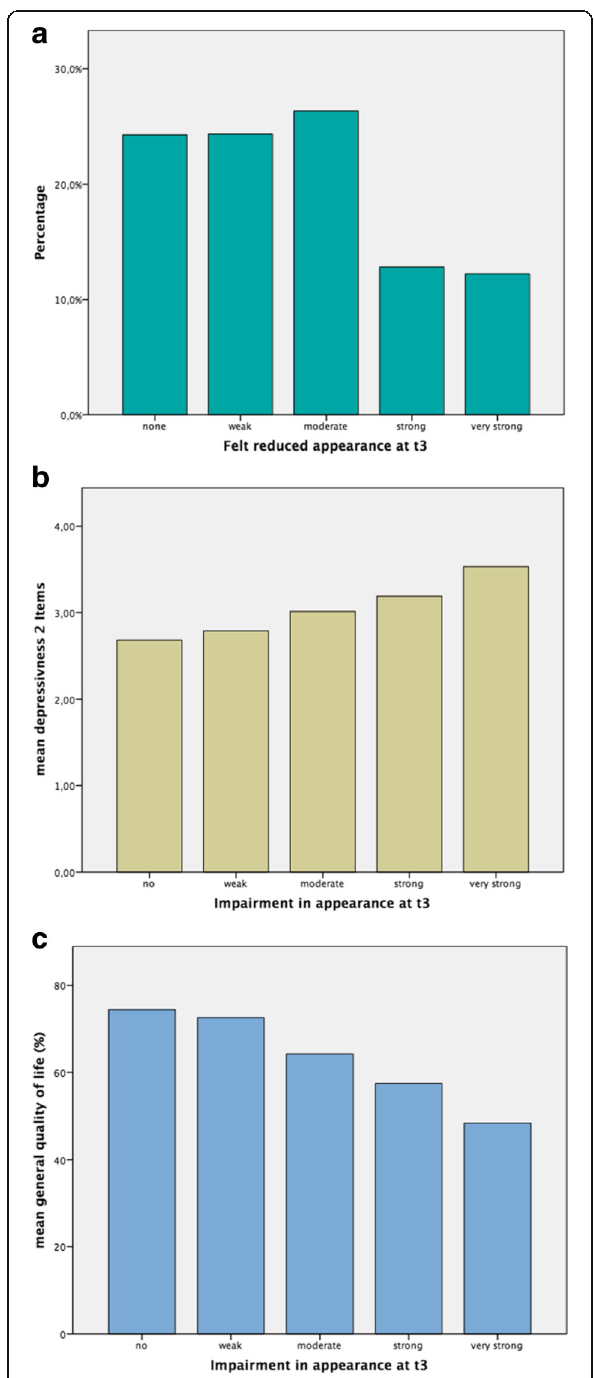
Fig. 2 Appearance at t3: a number and percentage of affected patients, b relation to depressiveness, and c relation to life